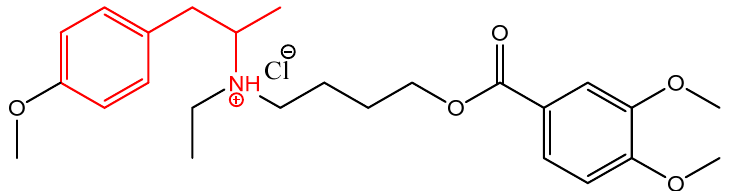
Figure 1. Structure of mebeverine hydrochloride; target compounds common structure in red.